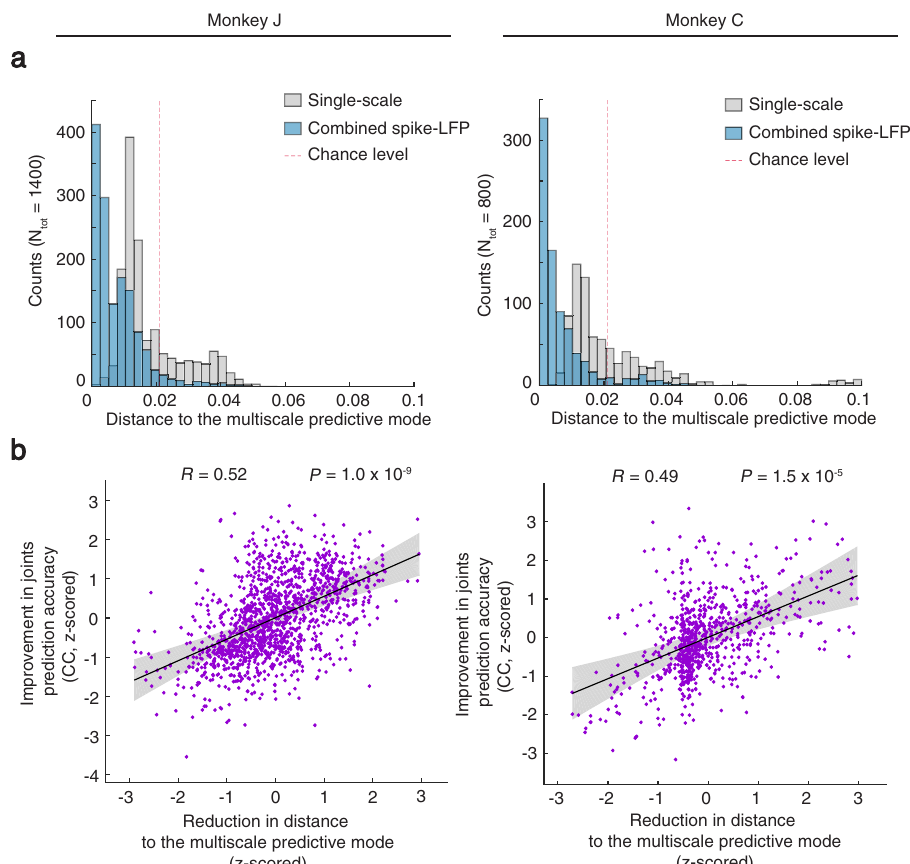
Fig. 6 Distance to the multiscale predictive mode explains behavior prediction accuracy. a For both monkeys, using the combined spike-LFP activity improved the estimation of the multiscale predictive mode across channel sets (Methods). The distance of the estimated modes to the multiscale predictive mode signi fi cantly decreased when using spike-LFP activity in combination compared with separately. Each channel set used a baseline of random fi ve LFP or spike single-scale channels and then added random 25 spike or LFP channels to them, respectively. The location of the multiscale predictive mode was de fi ned as the average of the single-scale predictive modes estimated using all channels to get the best estimate (average of brown and yellow dots in Fig. 5b). b For both monkeys, there was a positive correlation between the reduction in distance and improvement in joint angle prediction accuracy in CC ( P < 1.5 × 10 − 5 , N s = 1400 and 800 Monte Carlo samples in Monkey J and C, two-sided corrected resampled paired t test). Each dot represents one cross-validation fold from one channel set. To show the results across sessions, values are z scored for each session. R represents the Pearson ’ s correlation coef fi cient and P its p value corrected by the resampled t test (see Methods). Black line is the linear least-square fi t representing the mean prediction accuracy for different distances and the shaded area is the 95% con fi dence bound of the mean. Source data are provided as a Source Data fi conjugate principal mode (Fig. 8a; P = 9.1 × 10 − 11 , N s > 22, one- sided Wilcoxon rank sum test). This indicates that accurate